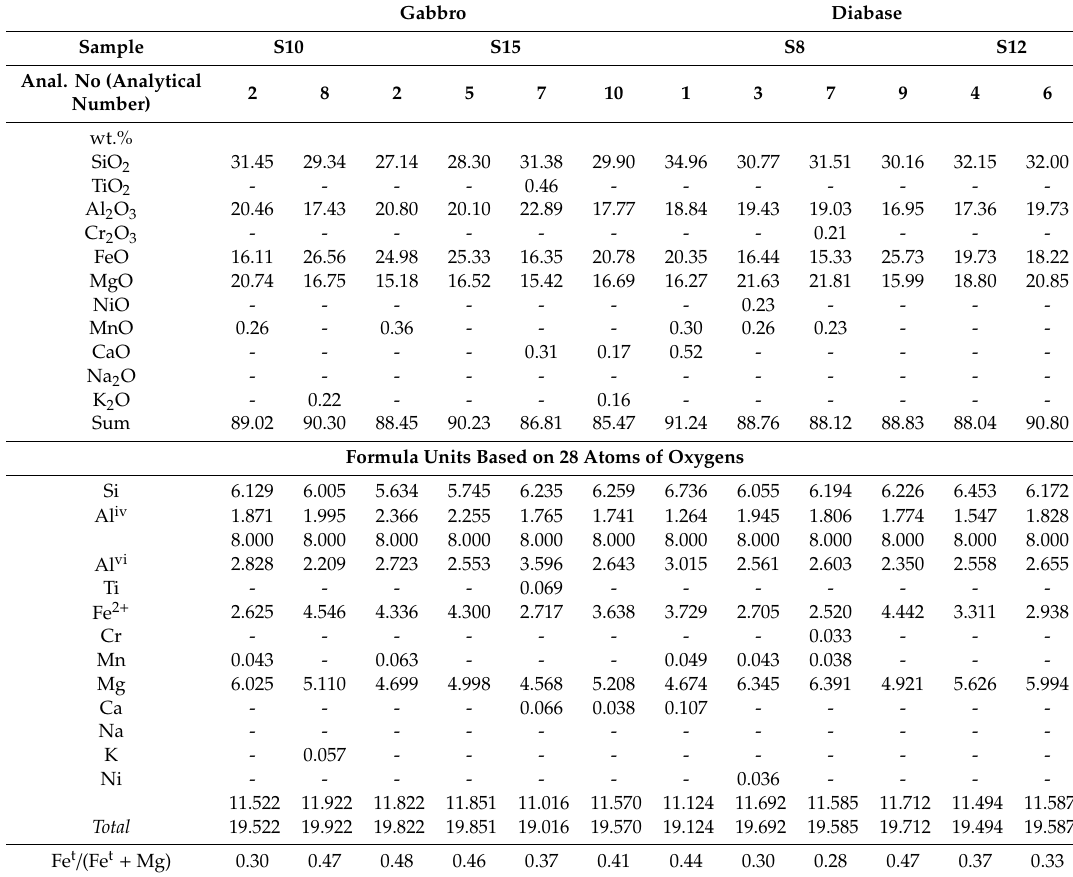
Table 2. Representative electron microanalyses of chlorite from examined mafic rocks (-: below detection